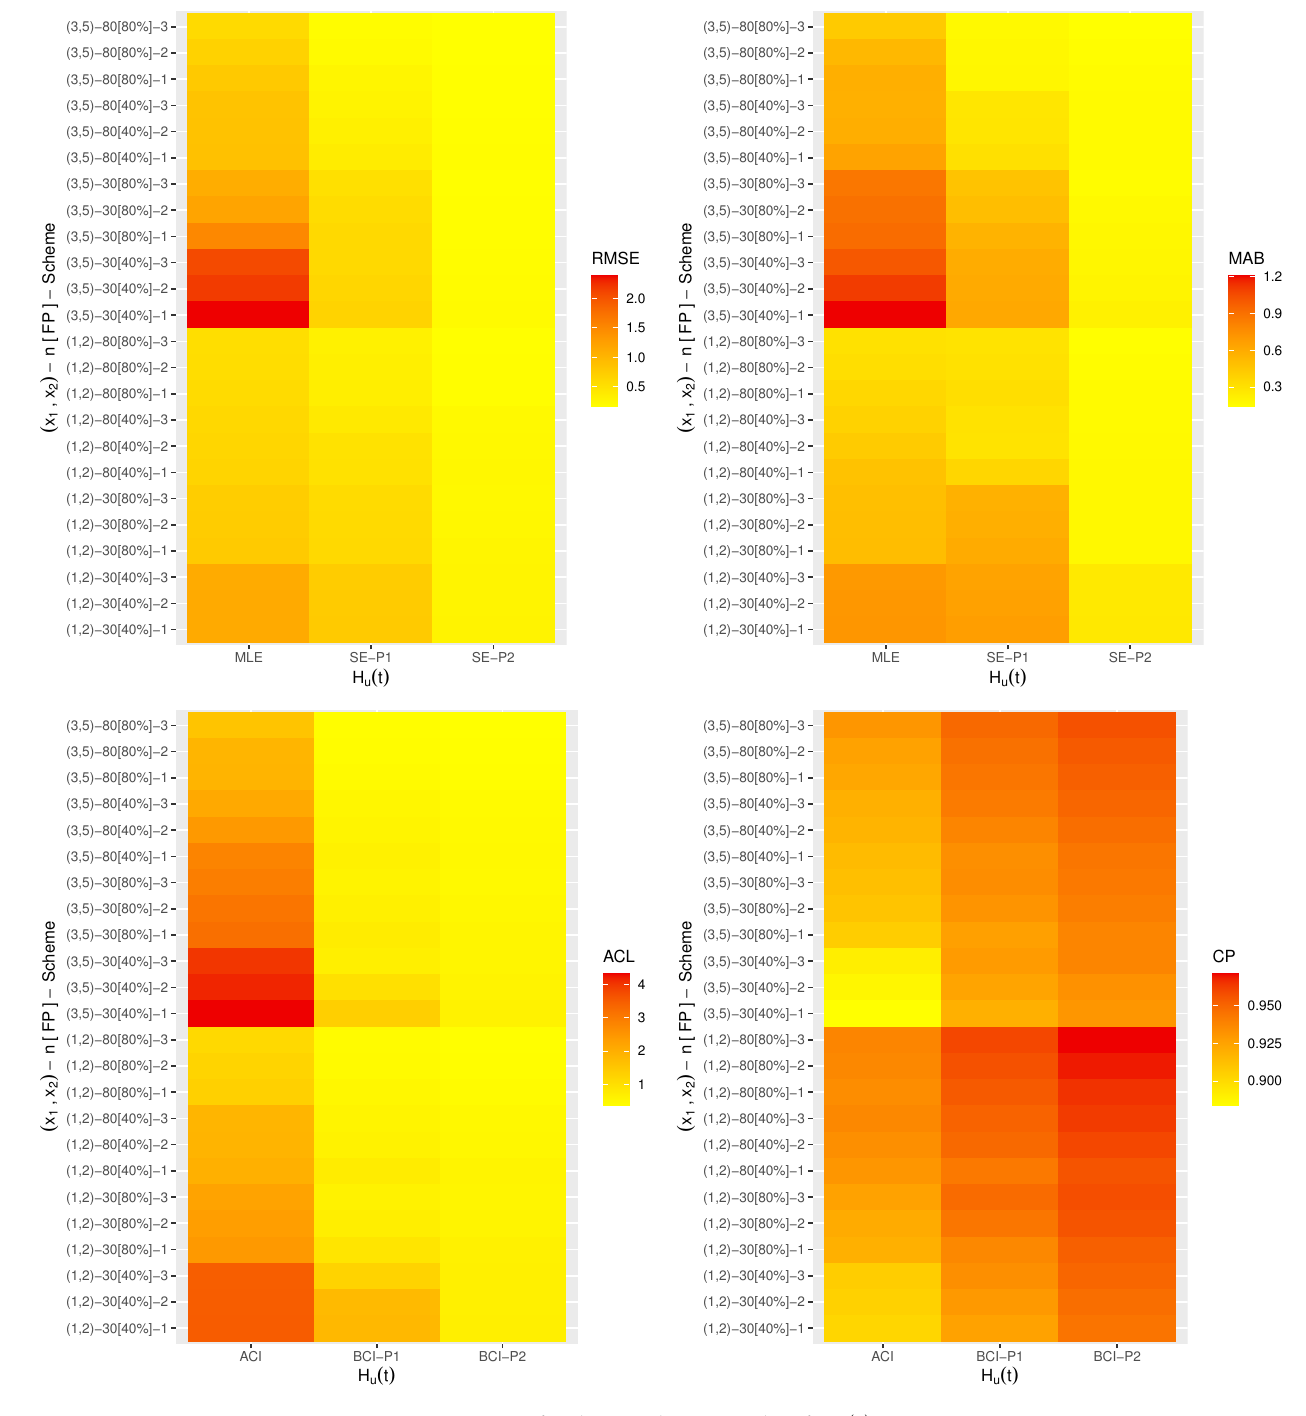
Figure 6. Heat map for the simulation results of H u ( t )